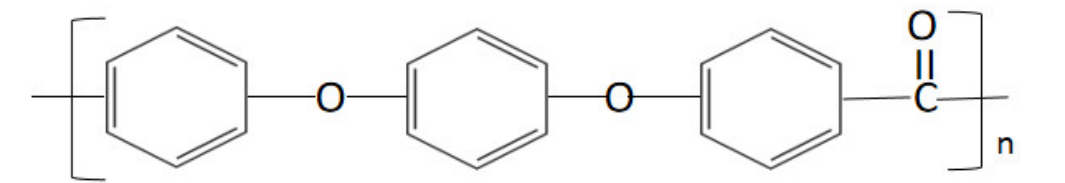
Figure 1. Chemical formula of polyetheretherketone (PEEK) Polyaromatic semi-crystalline thermoplastic polymer with chemical structure (–C6H4–O–C6H4–O–C6H4–CO–)n. (Reproduced from [1], with permission from © 2012 Elsevier).